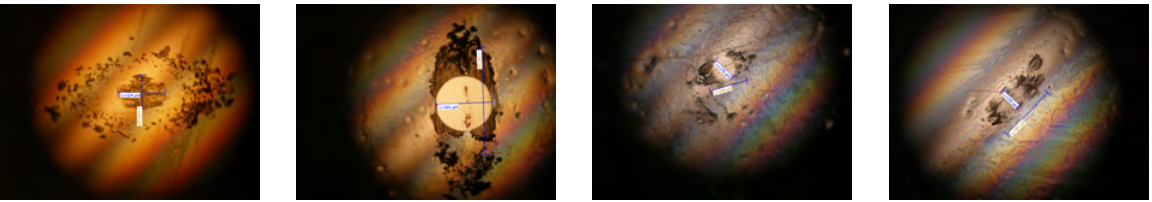
Figure 2. Wearability of the testing ball after tests for Ti6Al4V substrate and for samples Ti:DLC7(pure DLC), Ti:DLC10 (5 at.% Ti) and Ti:DLC12(25 at.% Ti). The figures are captured at magnification 200x. Dual PLD 0 at.% Ti 1 at.% Ti 3 at.% Ti 5 at.% Ti 10 at.% Ti 25 at.% Ti 0.12 0.14 0.13 0.12 0.11 0.09 PLD/MS 0 at.% Ti 1 at.% Ti 3 at.% Ti 5 at.% Ti 10 at.% Ti 25 at.% Ti 0.13 0.15 0.18 0.15 0.16 Table 1. Friction on the layers of Ti:DLC prepared by dualPLD and PLD/MS methods.